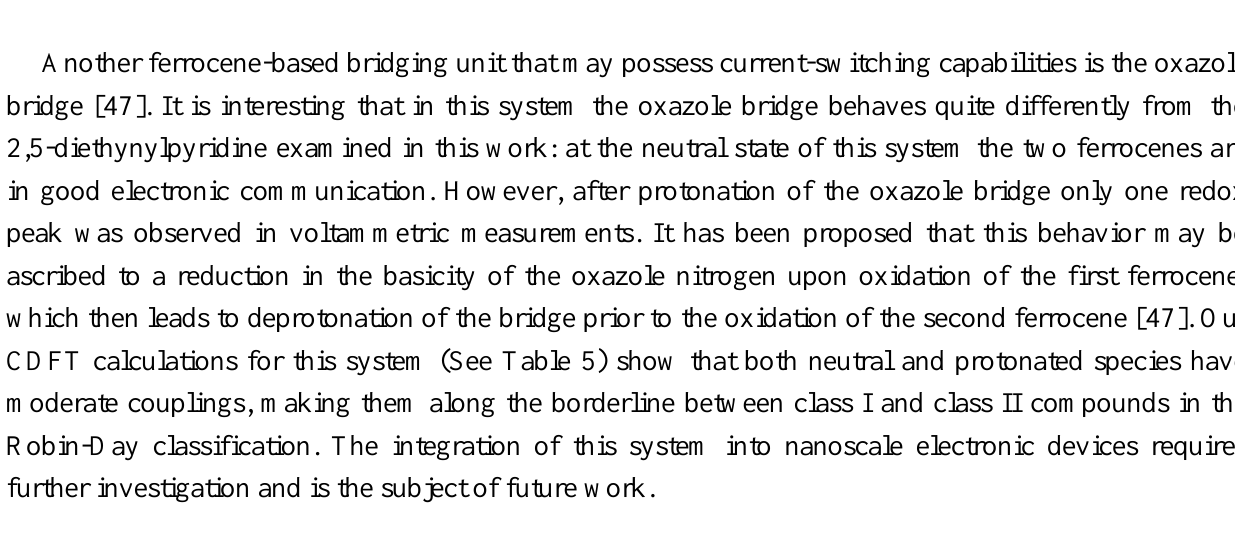
) between donor and acceptor states for diabatic